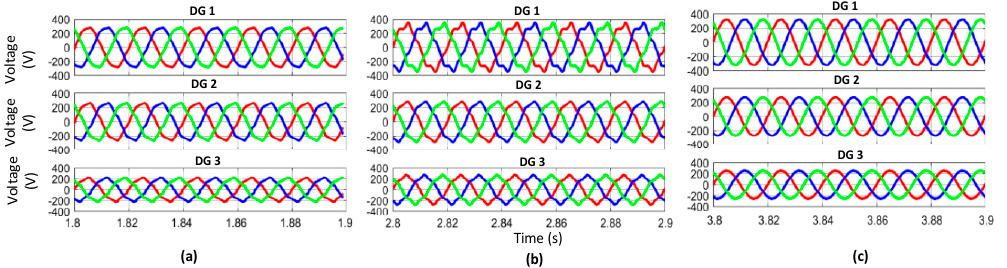
Figure 6. Voltage waveforms of DGs in various steps for the harmonic compensation from left to right. ( a ) First step (without harmonic current compensation); ( b ) second step (with harmonic current compensation); ( c ) third step (enabling the APF).